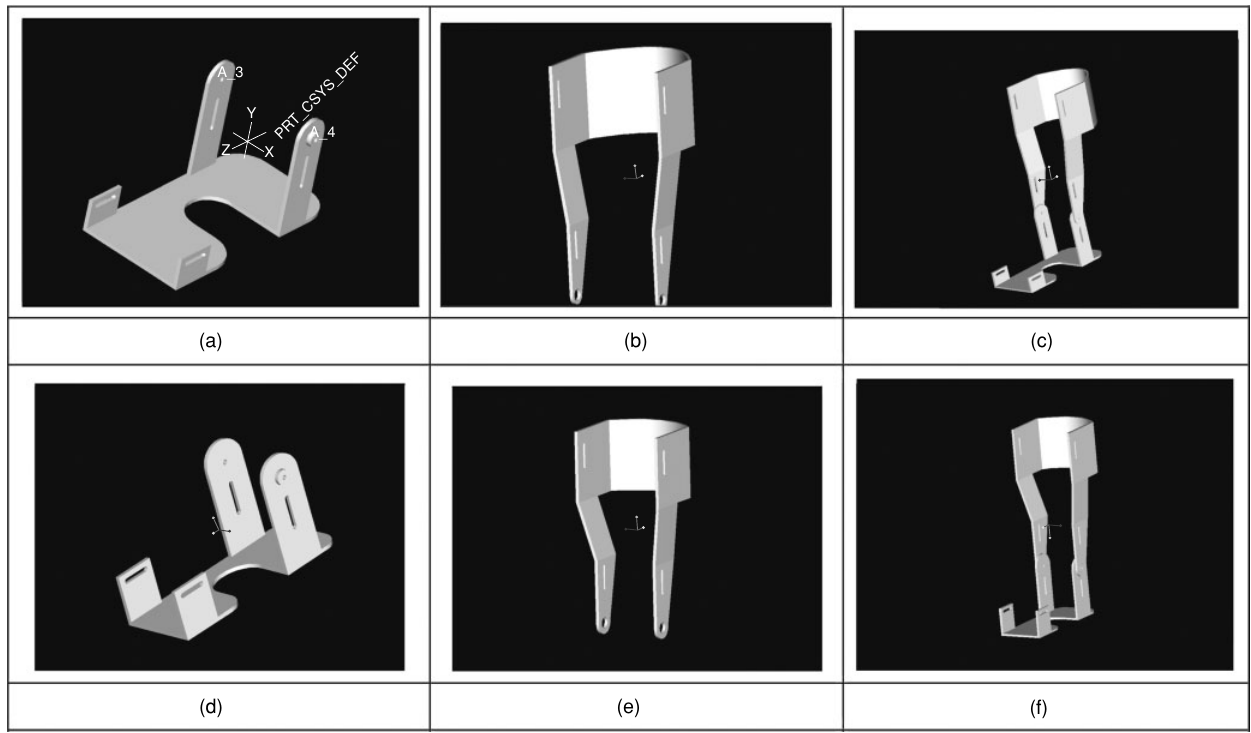
Figure 6 The parameterised orthotic for the Visible Human male (a, b, c) and Visible Human female (d, e, f): the foot component (a, d), the lower-leg component (b, e), and the assembly (c,